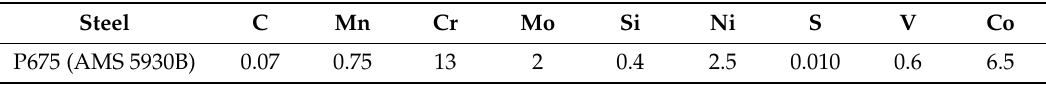
Table 1. Nominal composition (wt.%) of P675 alloy (remainder is Fe). Adapted from Trivedi, et al.